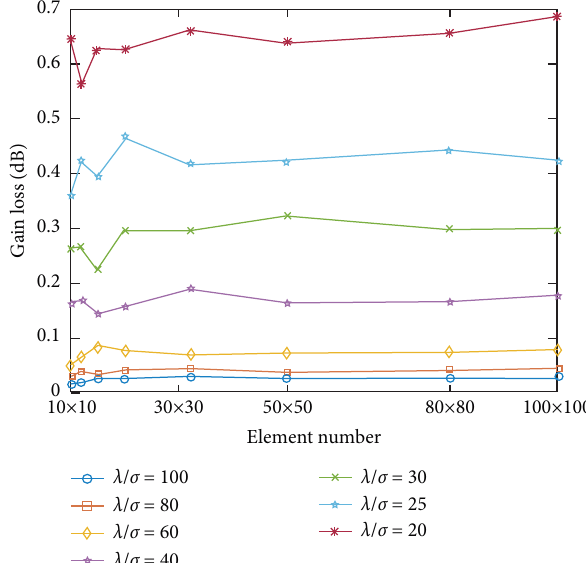
Figure 12: Gain loss in relation to array size and random error